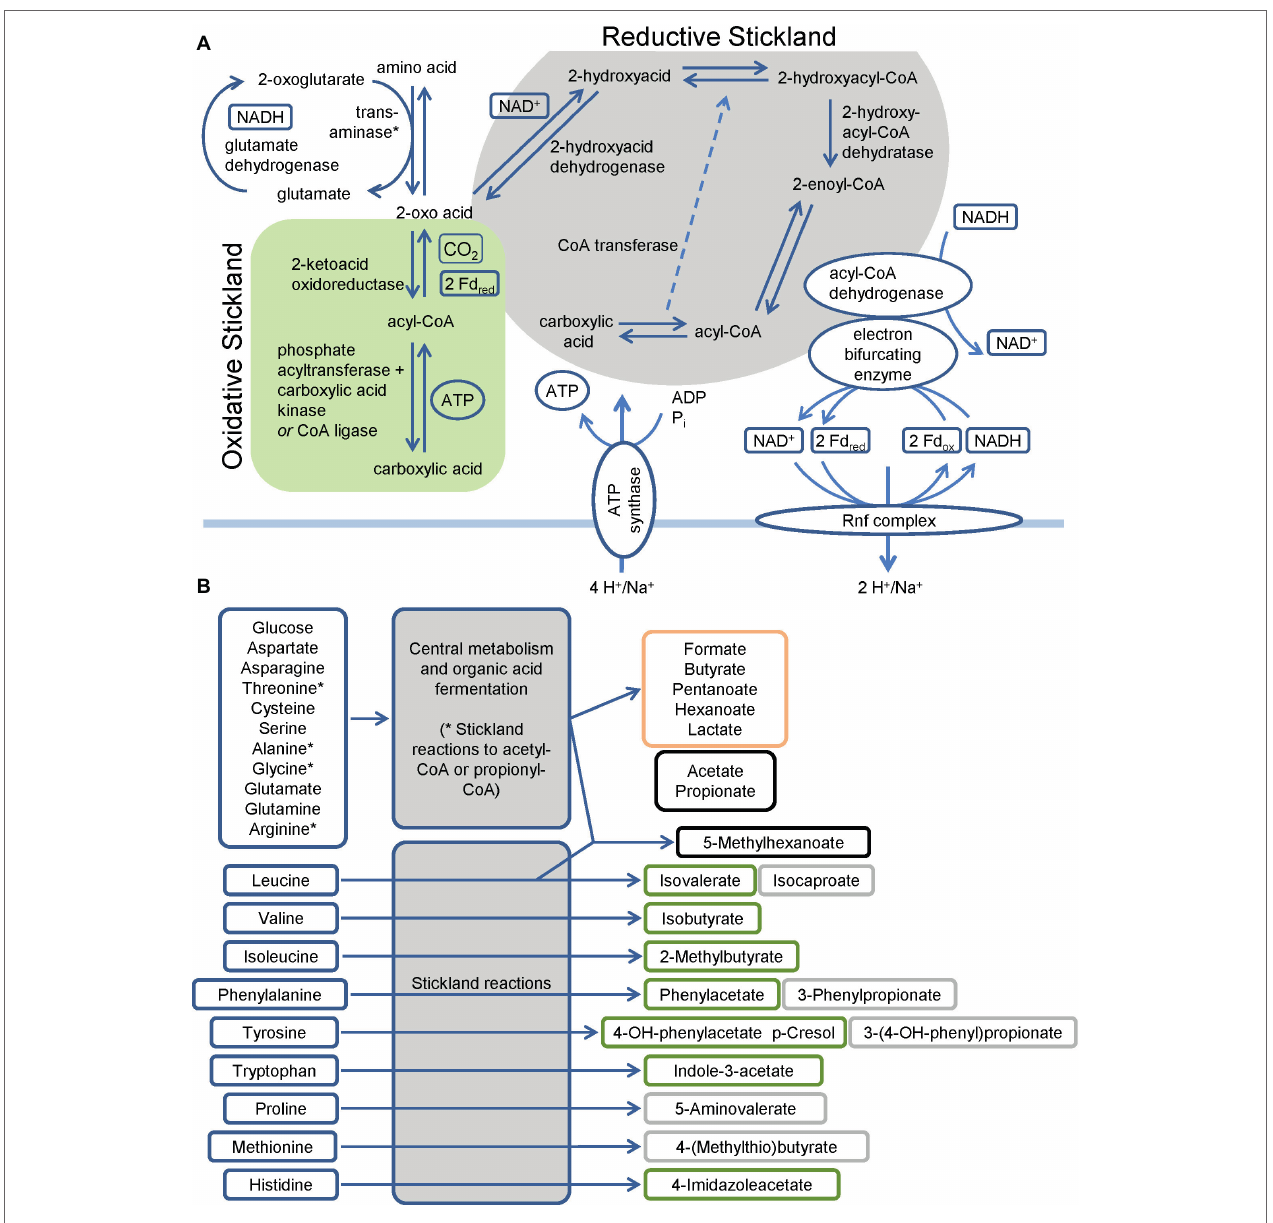
FIGURE 1 | Overview of the fermentation metabolism in Clostridioides difficile . (A) Schematic overview of Stickland reactions showing the reaction steps of classical reductive and oxidative pathways and of the Rnf complex and the connection to the electron bifurcating enzymes. Products are shown at the end of the arrow and in boxes alongside the arrows, * Serine, threonine, methionine and cysteine are also subject to deamination by lyases. (B) Overview of amino acids and glucose as representative sugar and their fermentation products. The figure summarizes published fermentation products and substrates omitting alcohols and intermediates of the pathways for reasons of clarity. Corresponding alcohols are only minor products. (-OH: -hydroxy, Fd ox : Ferredoxin oxidized form, Fd red : Ferredoxin reduced form). Green: oxidative Stickland reactions and their products, gray: reductive Stickland reactions and their products, orange: central carbon metabolism-associated fermentation products, black: Stickland products (oxidative and/or reductive) and central carbon metabolism-associated fermentation